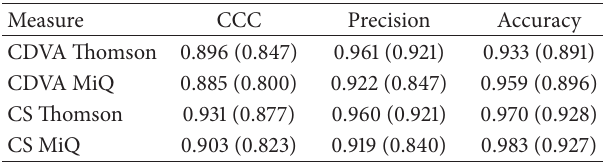
Table 2: Agreement indices for test-retest of CDVA and CS by Thomson and MiQ